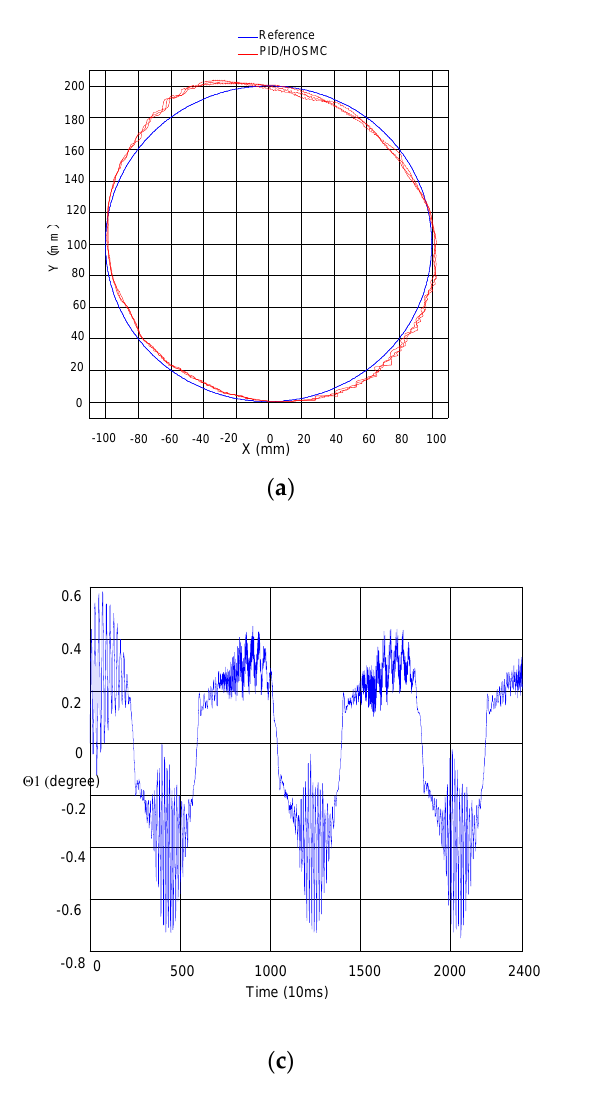
Figure 5. Results of the tracking circular trajectory of a robot arm (the θ 2 axis uses PID, and the θ 1 axis uses HOSMC controllers): ( a ) results of the tracking circular trajectory of a robot arm (the θ 2 axis uses PID, and the θ 1 axis uses HOSMC controllers); ( b ) tracking error of the θ 2 axis at a lower load; ( c ) tracking error of the θ 1 axis at a lower load.